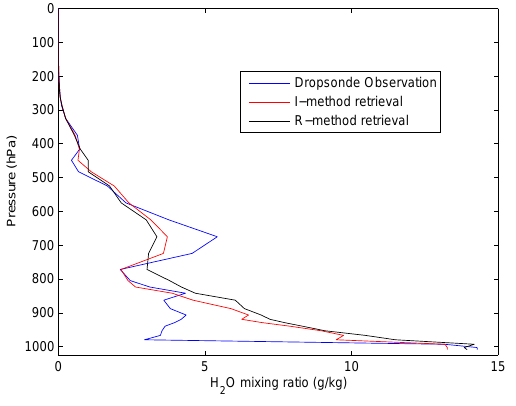
Figure 10. Results for the JAIVEx case study and for the case ( N = 3385 , x Day 29 April 2007. The figure shows the mean retrieved profile for H approaches and their comparison with the dropsonde observation. The retrieved profile has been averaged over the six available IASI soundings.